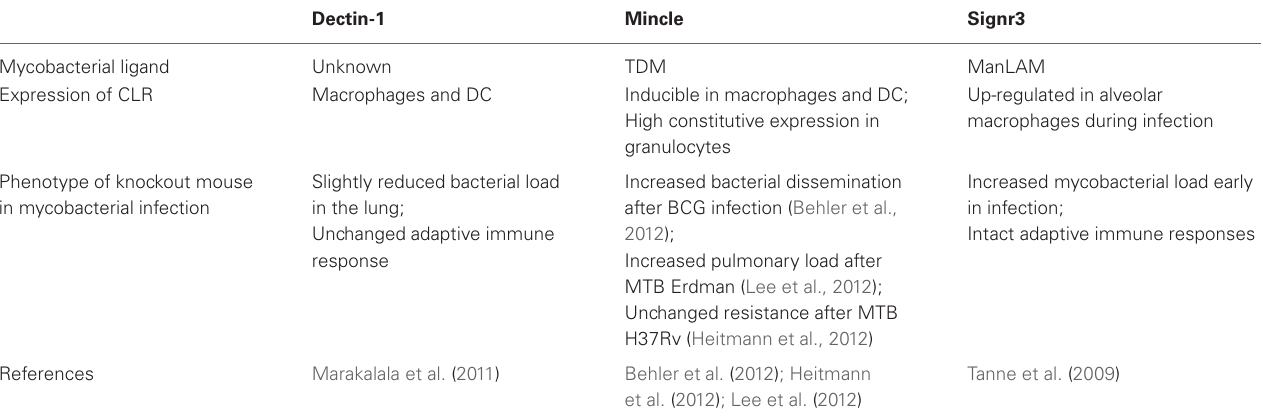
Table 1 | C-type lectin receptors in mycobacterial